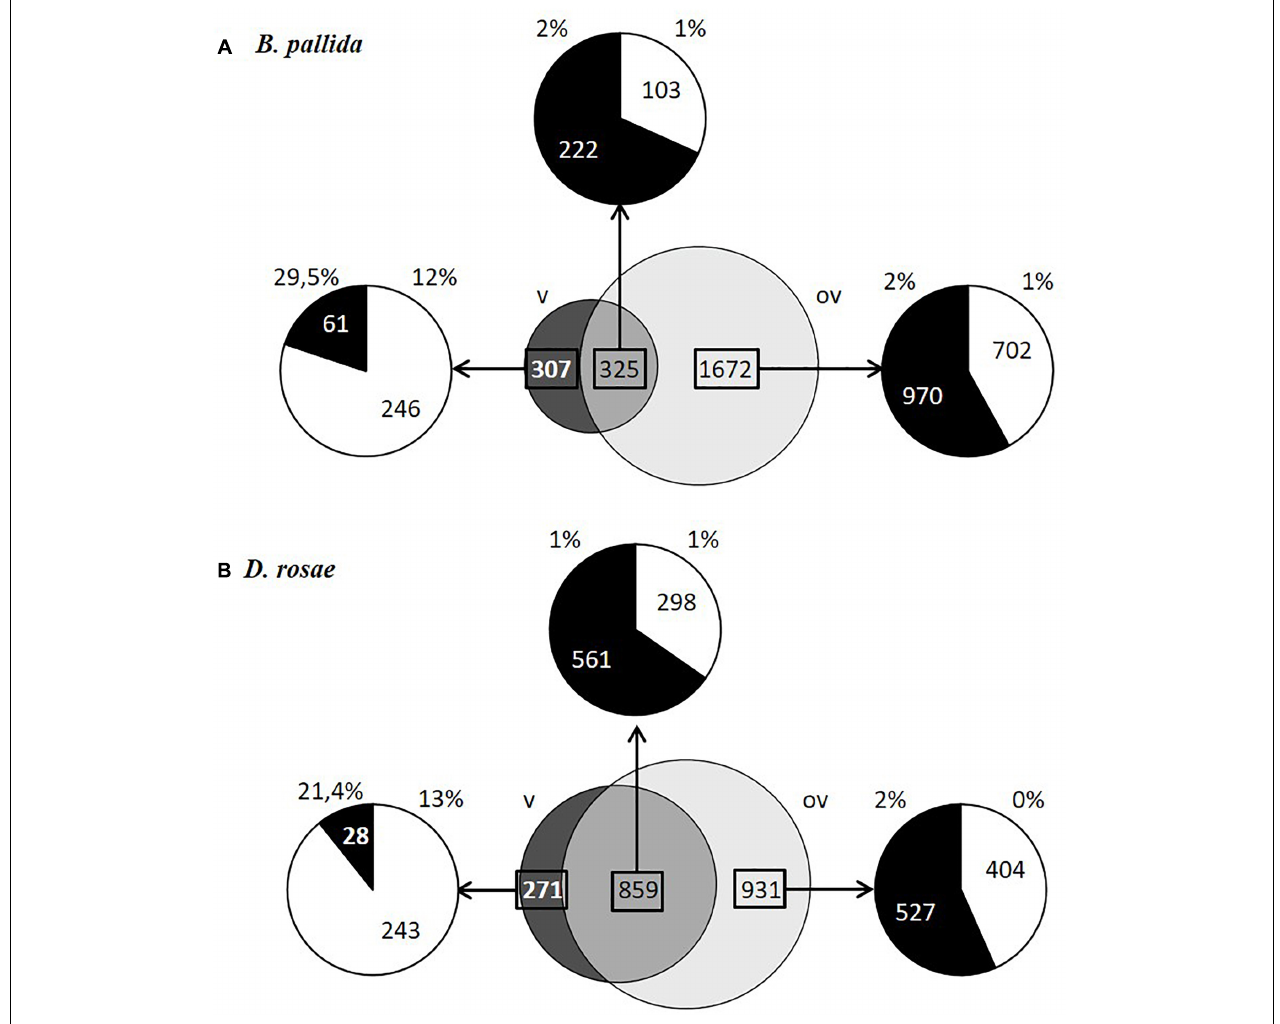
FIGURE 5 | Contig expression levels in ovaries and venom glands and percentage of contigs encoding proteins with signal peptides in B. pallida (A) and D. rosae (B) . In dark gray, contigs expressed at least 20 times higher in venom glands than in ovaries (v); in light gray, contigs expressed at least 20 times higher in ovaries than in venom glands (ov); in gray, contigs expressed in both ovaries and venom glands with relative expression levels differing by less than 20-fold. The distribution of contigs that had a blastx hit (black) or that are not assigned (NA; white) and the percentage of these contigs coding proteins with a signal peptide (SignalP4.0 prediction) are specified for each category of